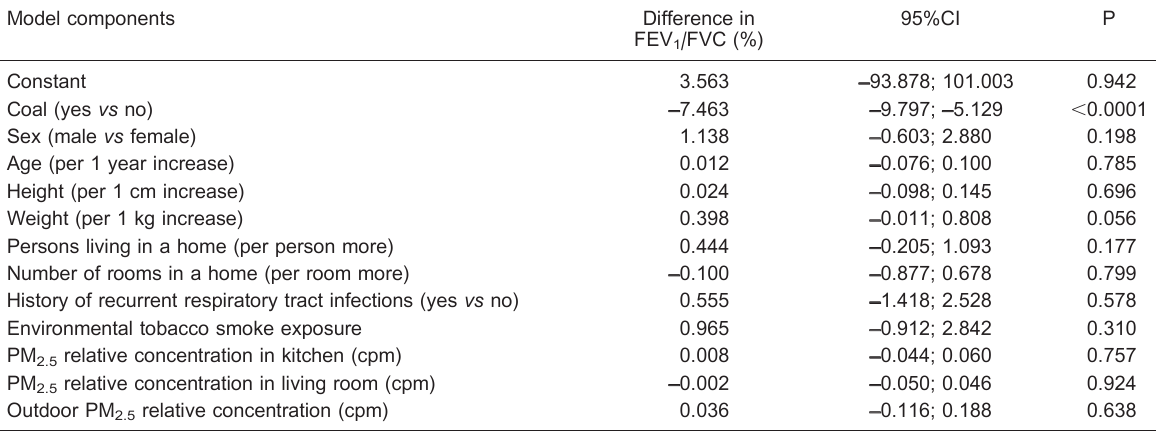
Table 4. Estimated parameters and 95% confidence interval (CI) of multivariate linear regression analysis of FEV 1 /FVC ratio. Model